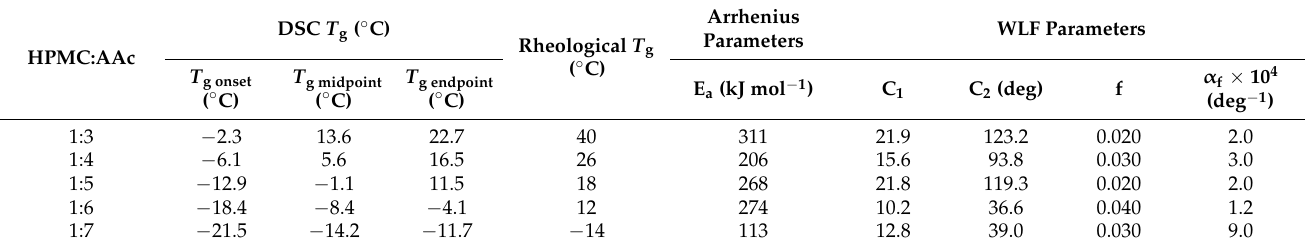
Table 1. Thermal glass transition temperatures, and WLF/Arrhenius parameters of the HPMC-AAc